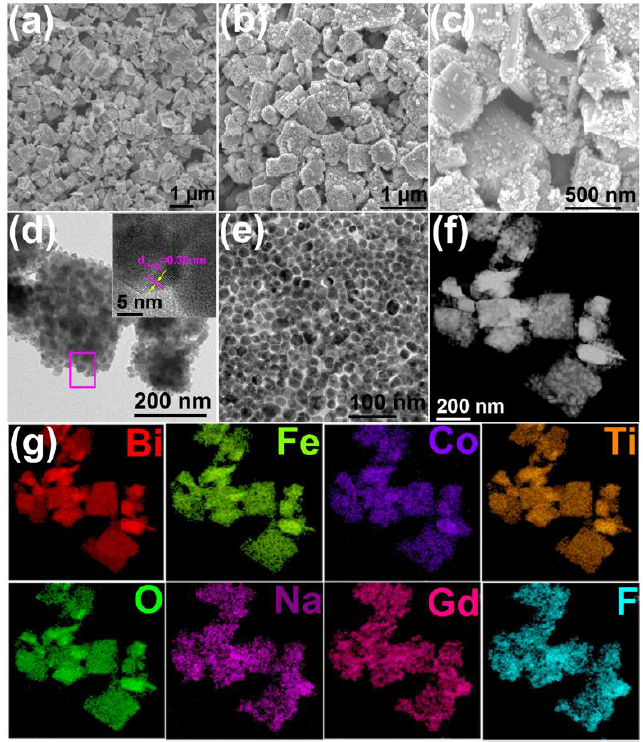
Figure 3. SEM images of ( a ) BFCTO-1.5 and ( b , c ) BFCTO-1.5/NGF nanoparticles;( d ) TEM image of BFCTO-1.5/NGF nanoparticles (insert: the HRTEM image of NGF nanoparticle in magenta frame); ( e ) TEM image of NGF nanoparticles; ( f ) HADDF-STEM image of BFCTO-1.5/NGF; ( g ) the corresponding EDS elemental mapping of Bi, Fe, Co, Ti, O, Na, Gd and F elements.